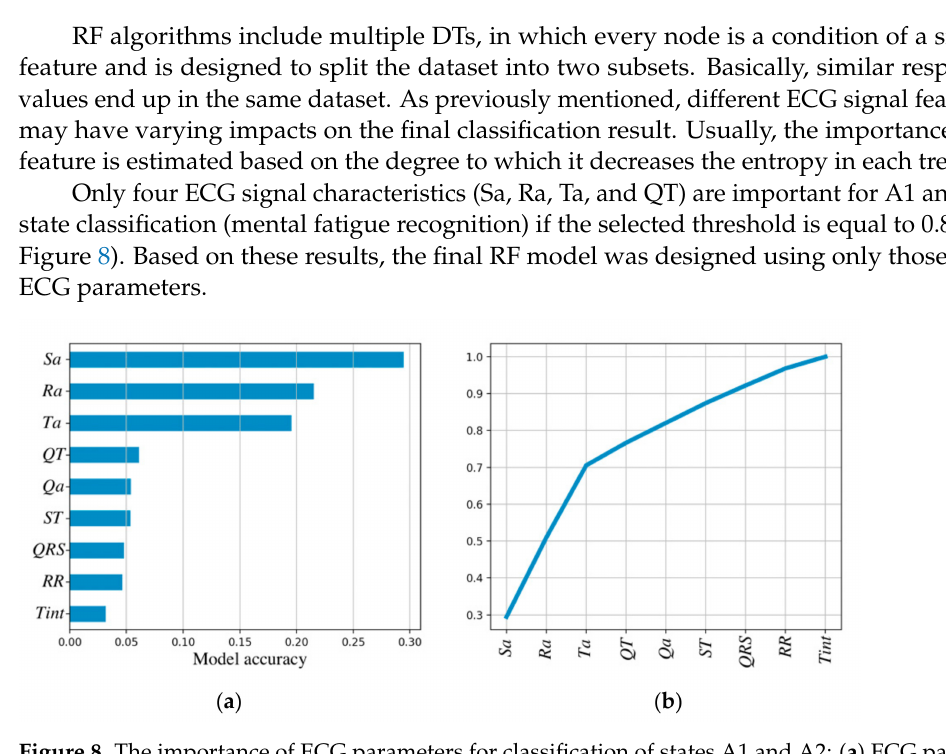
Figure 8. The importance of ECG parameters for classification of states A1 and A2: ( a ) ECG parame- ters and FR accuracy; ( b ) cumulative accuracy curve for the RF